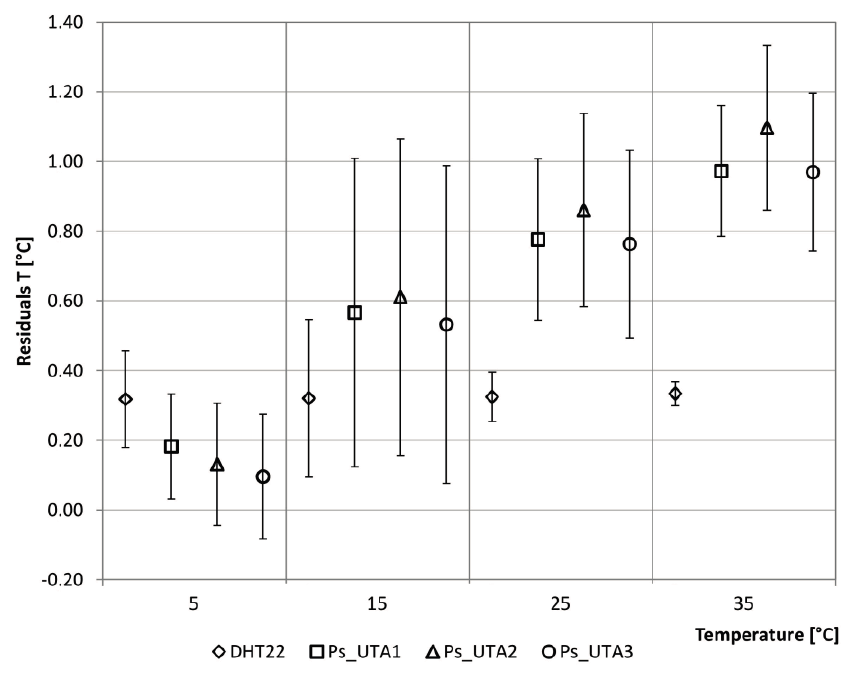
Figure 3. Residuals analysis of the temperatures.